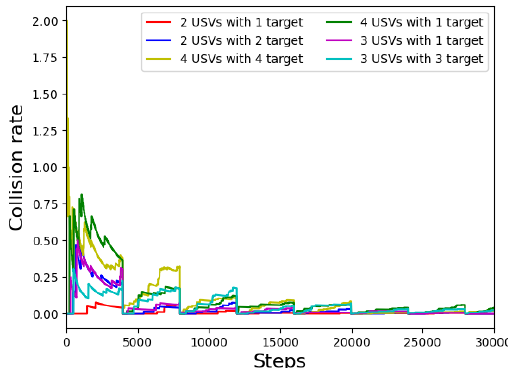
Figure 4. Collision rate per episode for the different numbers of USVs.